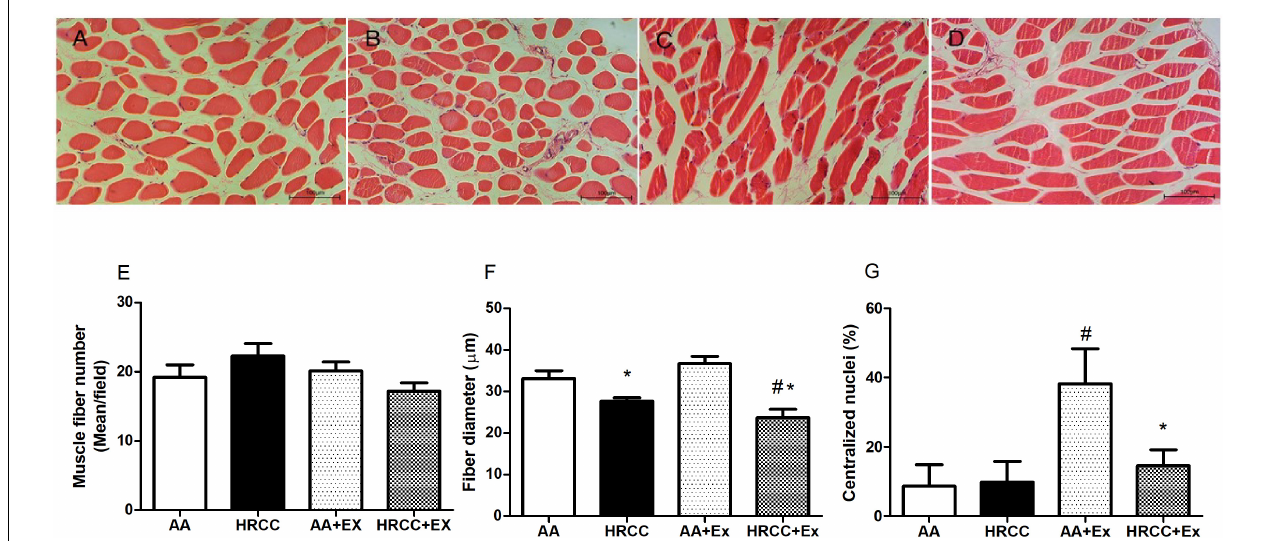
FIGURE 1 | Histology of the quadriceps of mice chronically exposed to hand-rolled cornhusk cigarette (HRCC) smoke and combined exercise. Panels (A–D) are photomicrographs stained with H & E: (A) ambient air (AA), (B) HRCC, (C) AA-plus combined exercise, (D) HRCC plus combined exercise. Panel (E) represents the number of fiber per field, panel (F) represents the mean of smallest diameter of 10 fibers per field and panel (G) represents the percentage of nuclei centralized. The data are expressed as mean and standard error of the mean and were analyzed statistically using two-way ANOVA, followed by the Newman–Keuls test. The groups were considered different when p ≤ 0.05* (difference in relation relation to the ambient air, # difference in relation to HRCC). Images under 20 × objective.